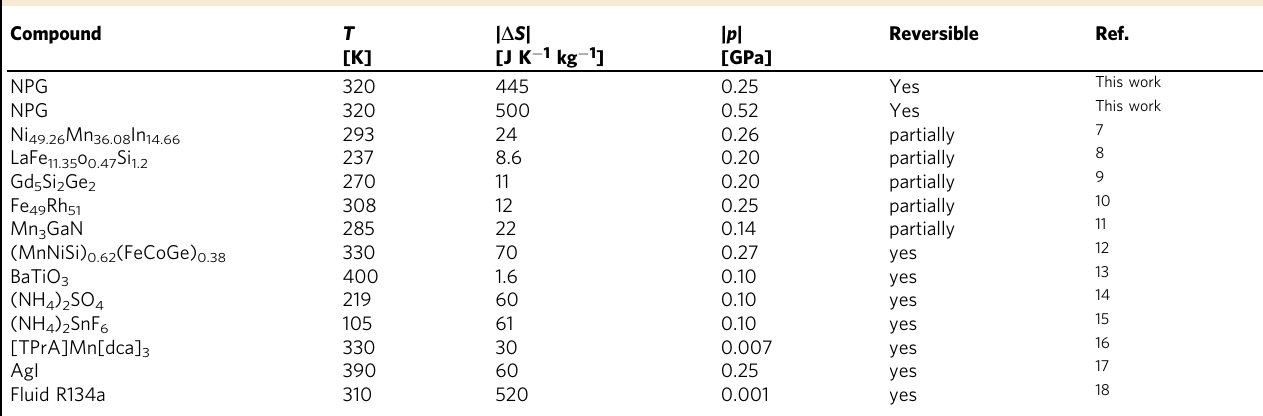
Table 1 Barocaloric effects near fi rst-order phase transitions